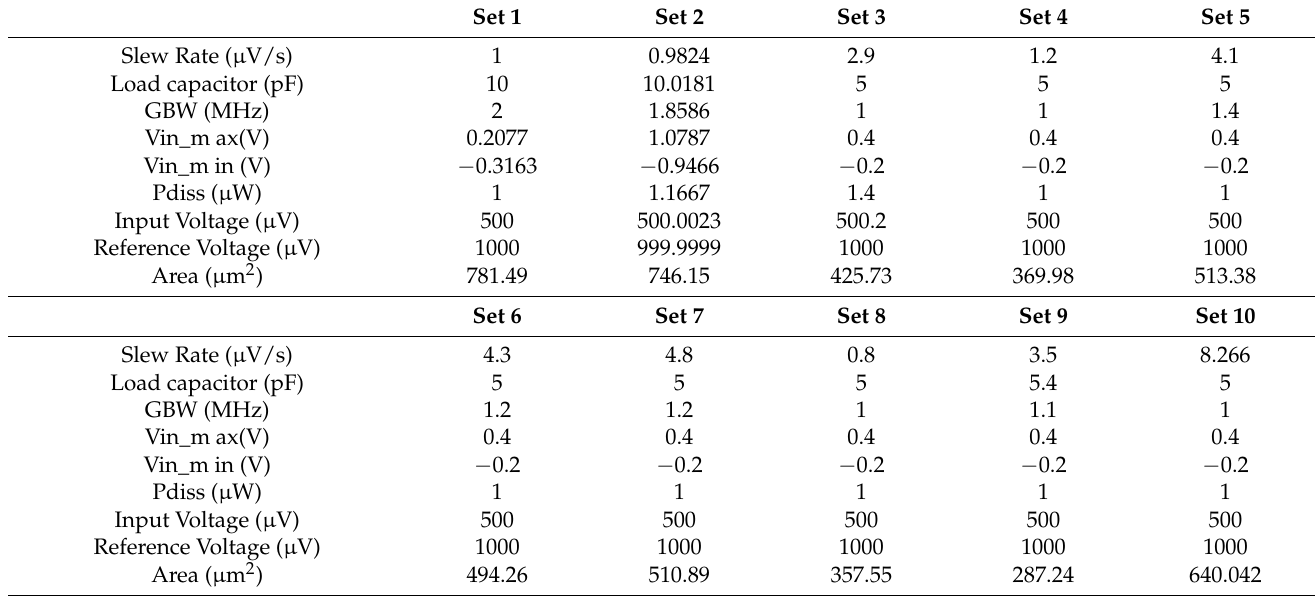
Table 6. Analysis from ANN-assisted goal attainment method.